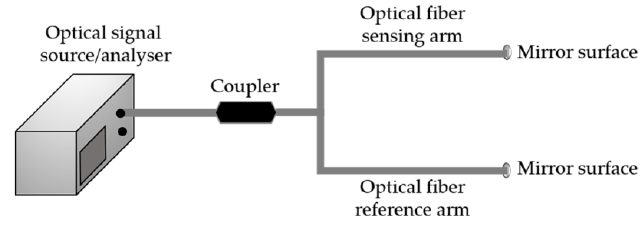
Figure 17. Schematic diagram of a MI experimental setup.